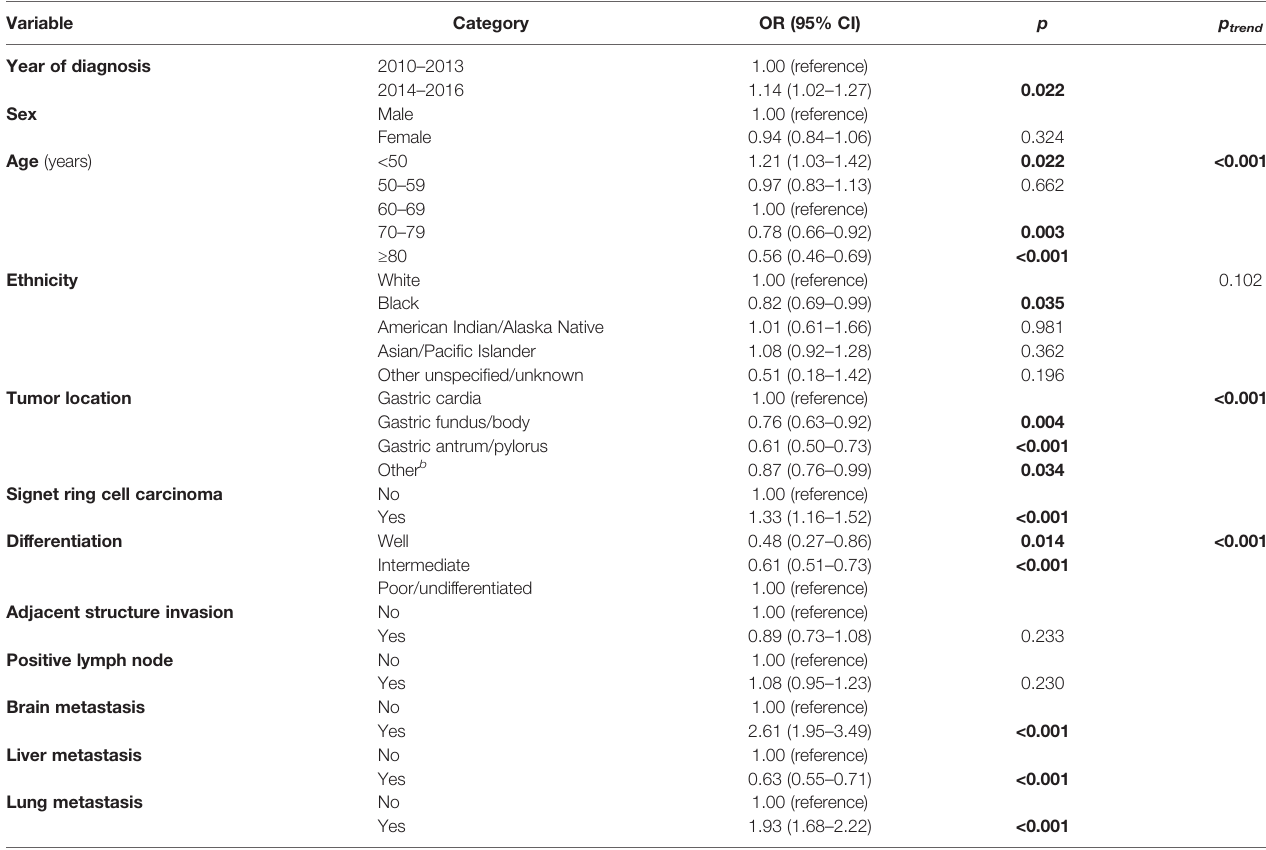
a Odds ratios and 95% con fi dence intervals for the variables listed in the fi rst column except tumor differentiation were calculated using the logistic regression model mutually adjusted for these variables. For tumor differentiation, adjacent structure invasion, and positive lymph node with missing values, the association was assessed by additionally including these variables one by one into the above multivariable-adjusted model. Statistically signi fi cant p values are highlighted in bold. b Lesser curvature, greater curvature, overlapping lesion of stomach, and stomach (not otherwise speci fi ed). OR, odds ratio; CI, con fi dence interval; -, not